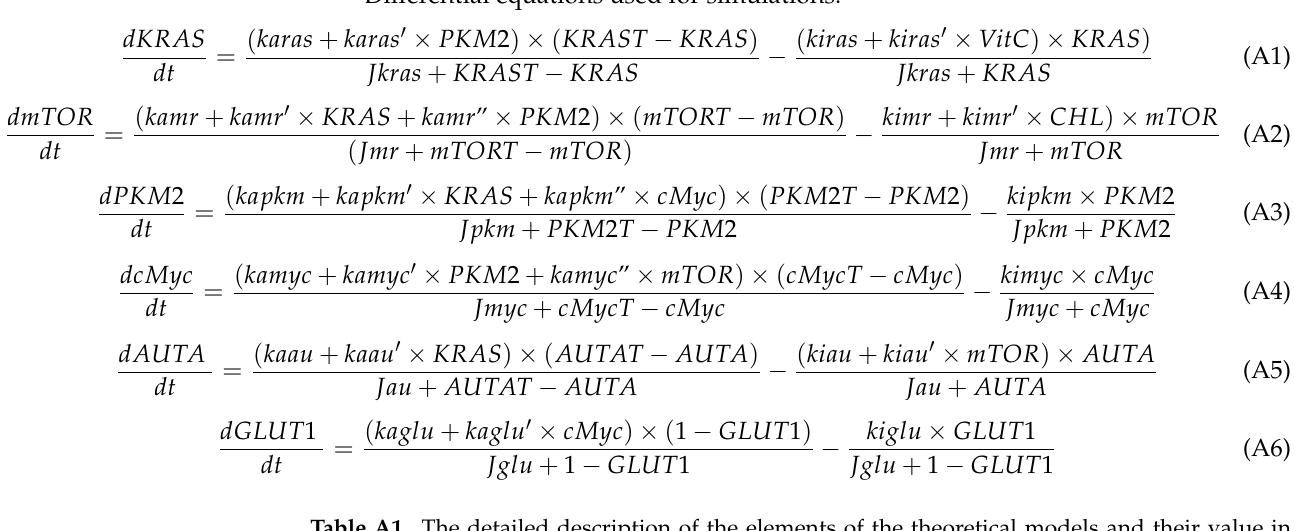
Table A1. The detailed description of the elements of the theoretical models and their value in physiological conditions.